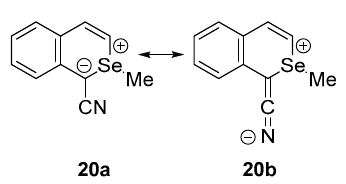
Figure 15. Stable selenabenzene 20 .